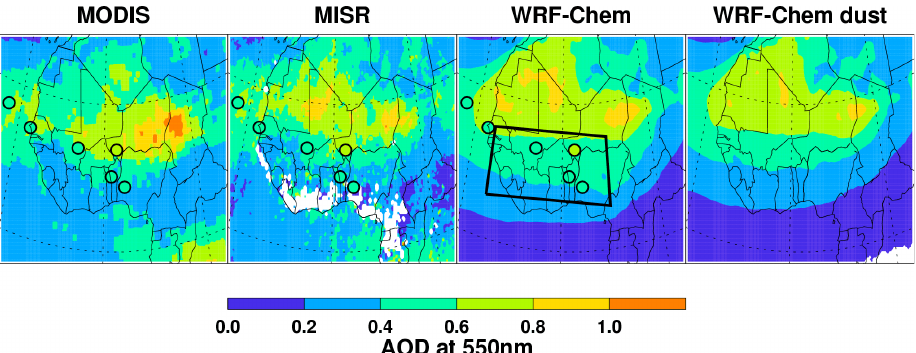
Figure 1 Averaged AOD at 550 nm over West Africa from the retrievals of MODIS on Aqua and MISR on Terra, the measurements of six AERONET sites, and the corresponding WRF-Chem simulated AOD of total aerosols and dust-only. The MODIS retrievals are a combination of the standard (over ocean) and “Deep Blue” (over land) products. AERONET measurements and model results are sampled between 10am-14pm. The blank areas in the plots are due to missing data. The six filled circles represent the averaged AOD at the six AERONET sites. The region in the black box is defined as the West Africa Monsoon (WAM) region.